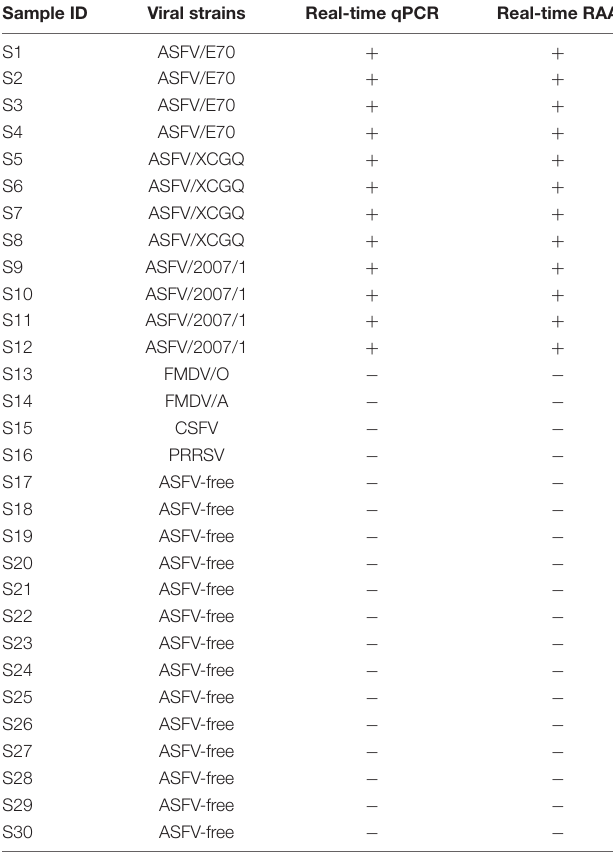
TABLE 5 | Coincidence rate between the real-time recombinase-aid amplification (RAA) assay and real-time quantitative PCR (qPCR). Sample ID Viral strains